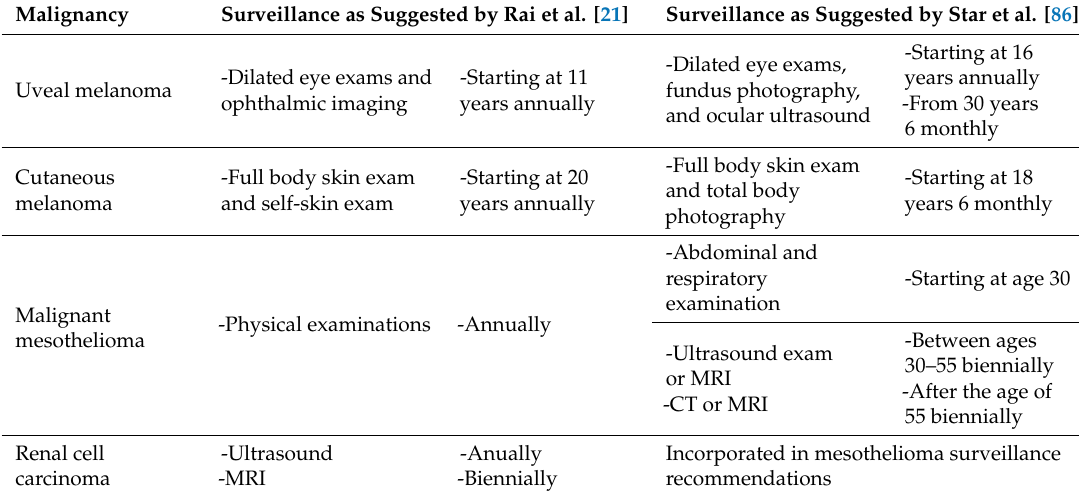
Table 6. Proposed surveillance recommendations BAP1-tumor-predisposition-syndrome-associated